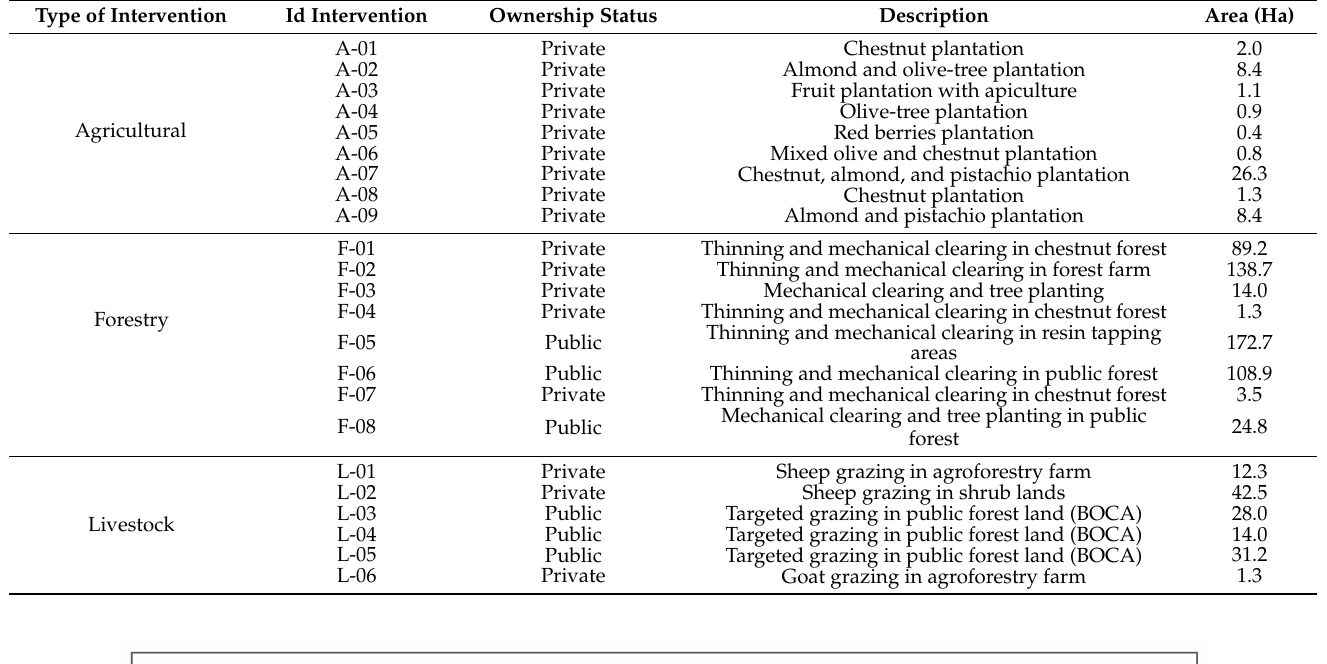
Table 1. Characteristics of interventions selected for the study.